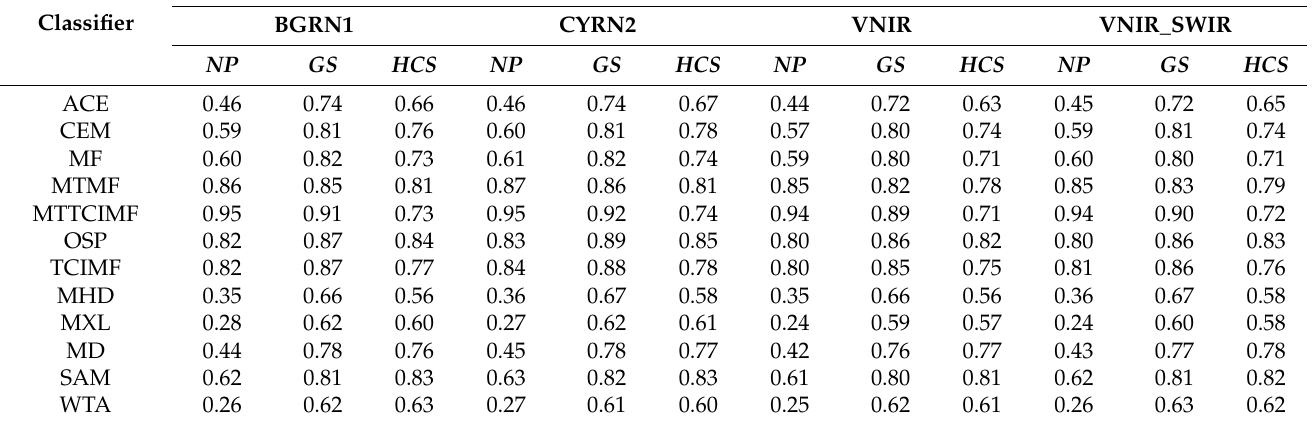
Table 8. Effect of pansharpening across each image subset based on average error rate. NP: Not pansharpened, GS: Gram–Schmidt, HCS: Hyperspherical Color Sharpening. All the values are calculated as averages across the atmospheric